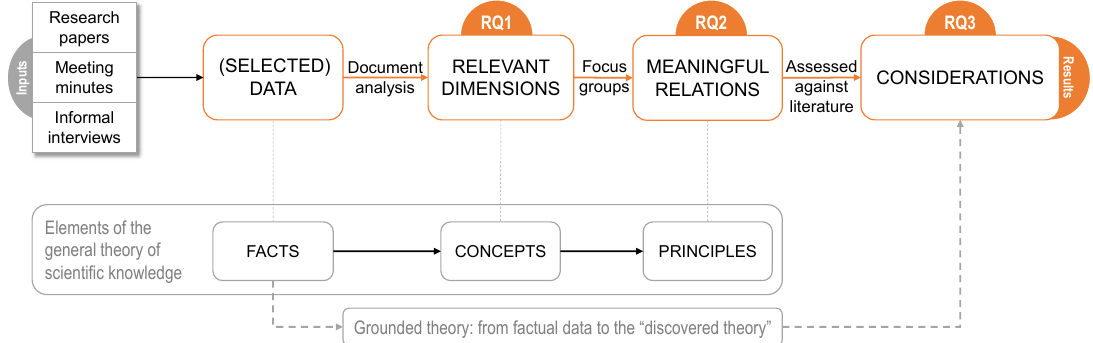
Figure 1. Qualitative research methods in relation to the RQs and their correspondence with the elements of the general theory of scientific knowledge [36] and the basics of the grounded theory method